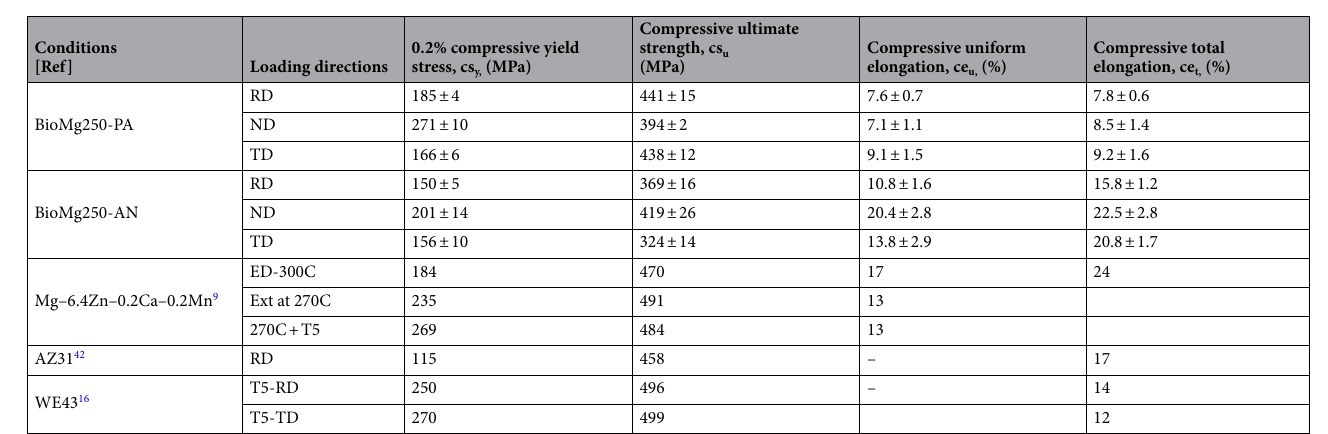
Table 3. Room temperature compression properties of